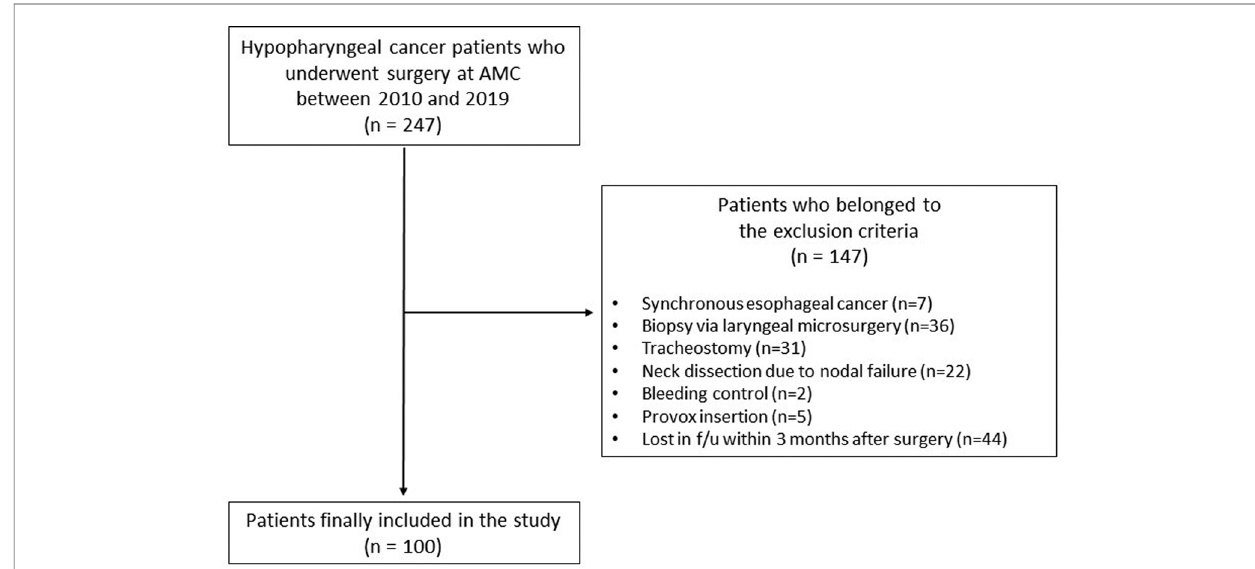
FIGURE 1 | Flowchart of the enrolled